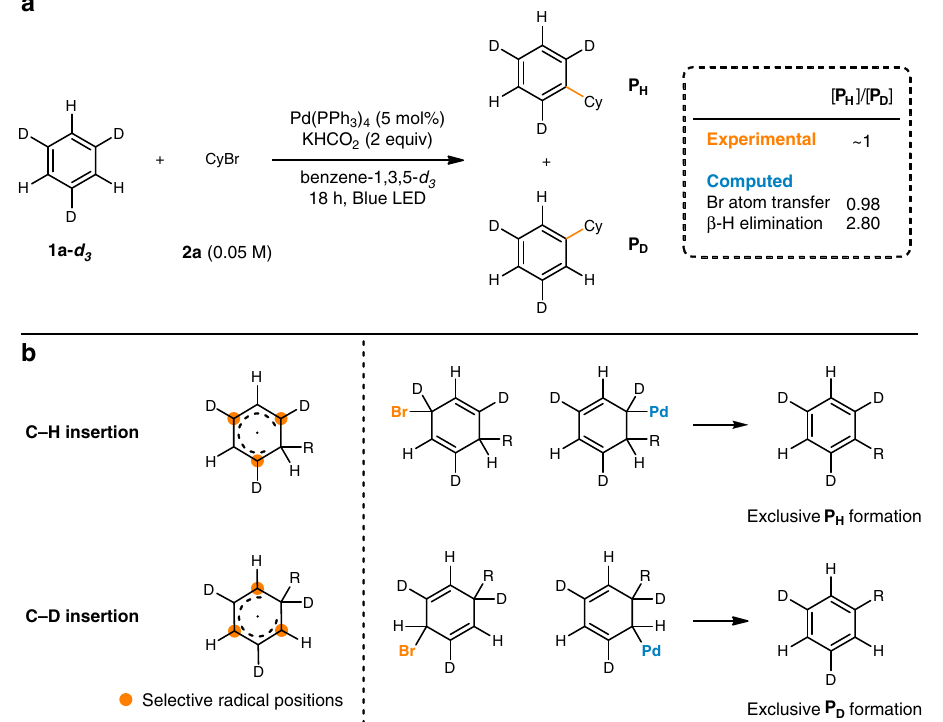
Fig. 4 Kinetic isotope effect study with benzene-1,3,5- d 3 . a Intramolecular kinetic isotope effect experiment. b Possible intermediates and products of the